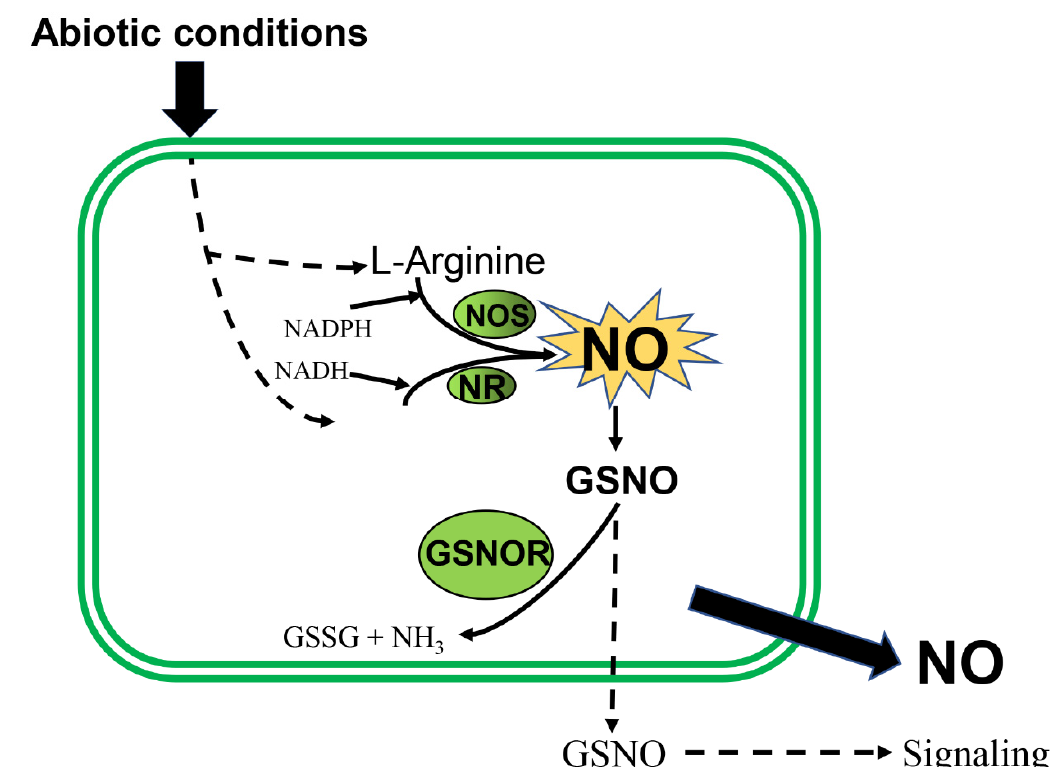
Figure 1. Endogenous NO production pathway in plants. NO, nitric oxide; NOS, nitric oxide synthase; NR, nitrate reductase; GSNO, S-nitrosoglutathione; GSNOR, S-nitrosoglutathione reductase; NADPH, NADPH oxidase; NADH, Nicotinamide adenine dinucleotide; GSSG, Oxidized glutathione; NH 3 , Ammonia.